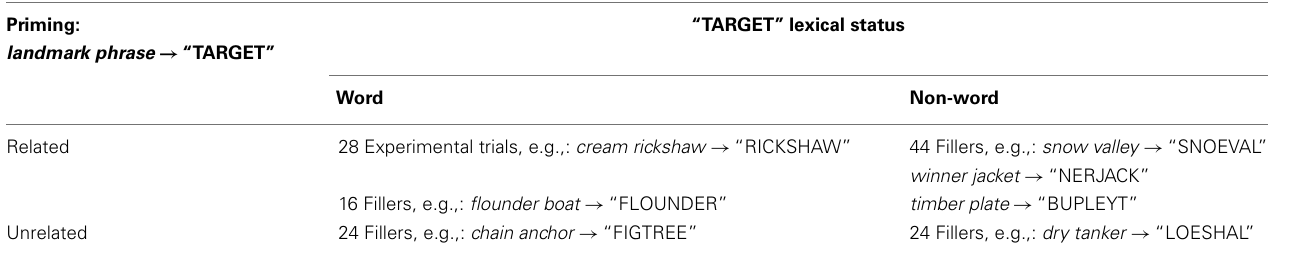
24 Fillers, e.g.,: dry tanker → “LOESHAL”